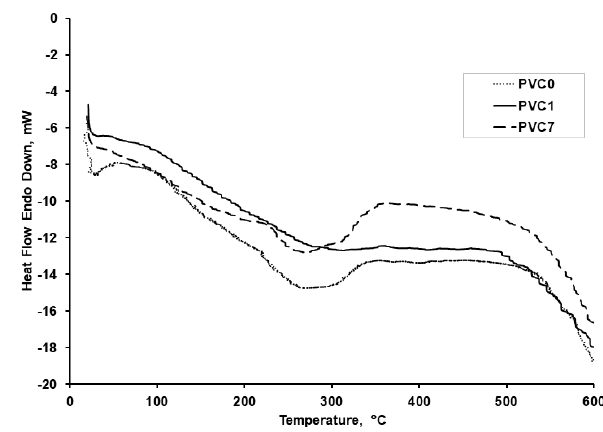
Figure 4: Effects of individual ZB and multiple ZB-ATH-MH contents on DSC curves of PVCs.